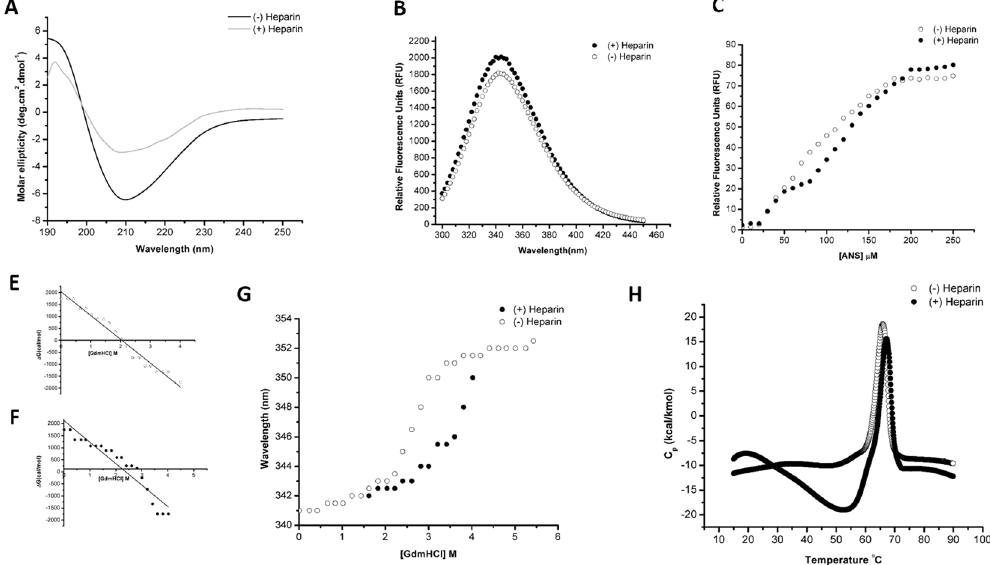
Figure 3. Effect of heparin on the conformation and stability of hIL12. ( A ) Overlay of the far-UV CD spectra (190 nm–250 nm) of hIL-12, in the absence (solid black) and presence (solid gray) of heparin. ( B ) Overlay of the steady-state fluorescence emission spectra on hIL-12 in the absence (empty circle) and presence (filled circle) of heparin. ( C ) Overlay of the equilibrium unfolding curves of IL-12, in the presence (filled circle) and absence (empty circle) of heparin. ( D , E ). A plot of the concentration of GdmCl [M] versus Δ G (cal/mol) to determine the concentration (C m ) of the denaturant required for denaturation of 50% of the protein population, present in the native conformation. ( G ) Overlay of the ANS binding curves of hIL-12 in the absence (empty circle) and presence (filled circle) of heparin. ( H ) Overlay of the thermal denaturation curves of hIL12 in the absence (empty circle) and presence (filled circle) of heparin. Thermal denaturation was carried out by ramping the temperature at a rate of 1 °C/min. Data obtained was plotted as heat capacity at constant pressure (Cp) versus temperature (°C) to obtain the T m of